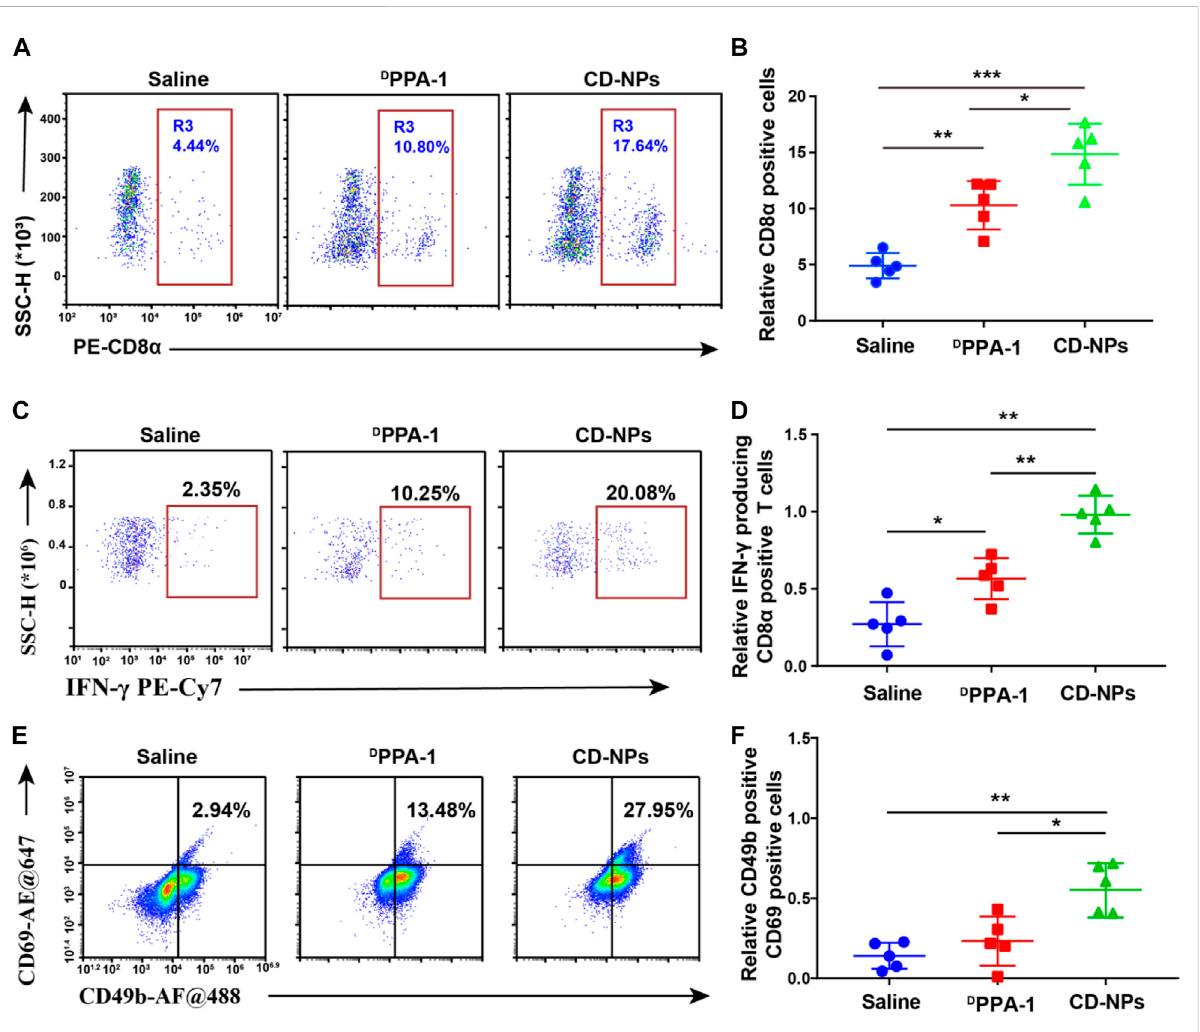
FIGURE 3 Evaluation of antitumor immune responses within tumor tissues. (A) Flow cytometry and (B) corresponding quantitative analysis of CD8 α - positive T cells in the tumor tissue with indicated treatments. (C) Flow cytometry and (D) corresponding quantitative analysis of IFN- γ -producing CD8 α -positive T cells in tumor tissue with indicated treatments. (E) Flow cytometry and (F) corresponding quantitative analysis of both CD69- positive and CD49-positive NK cells in the tumor tissue with indicated treatments. Data are shown as the mean ± SD; * p < 0.05, ** p < 0.01, *** p <